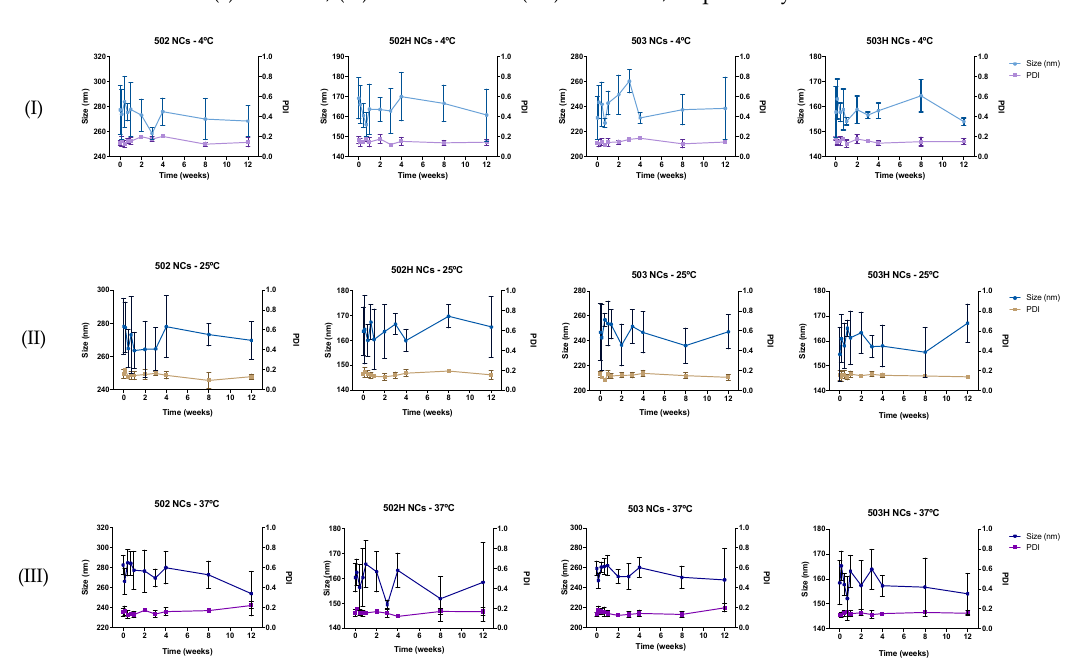
Figure 7. Stability-to-storage study for PLGA-based NCs at three different temperature conditions: ( I ) 4 ± 2 °C, ( II ) 25 ± 2 °C and ( III ) 37 ± 2 °C, respectively.